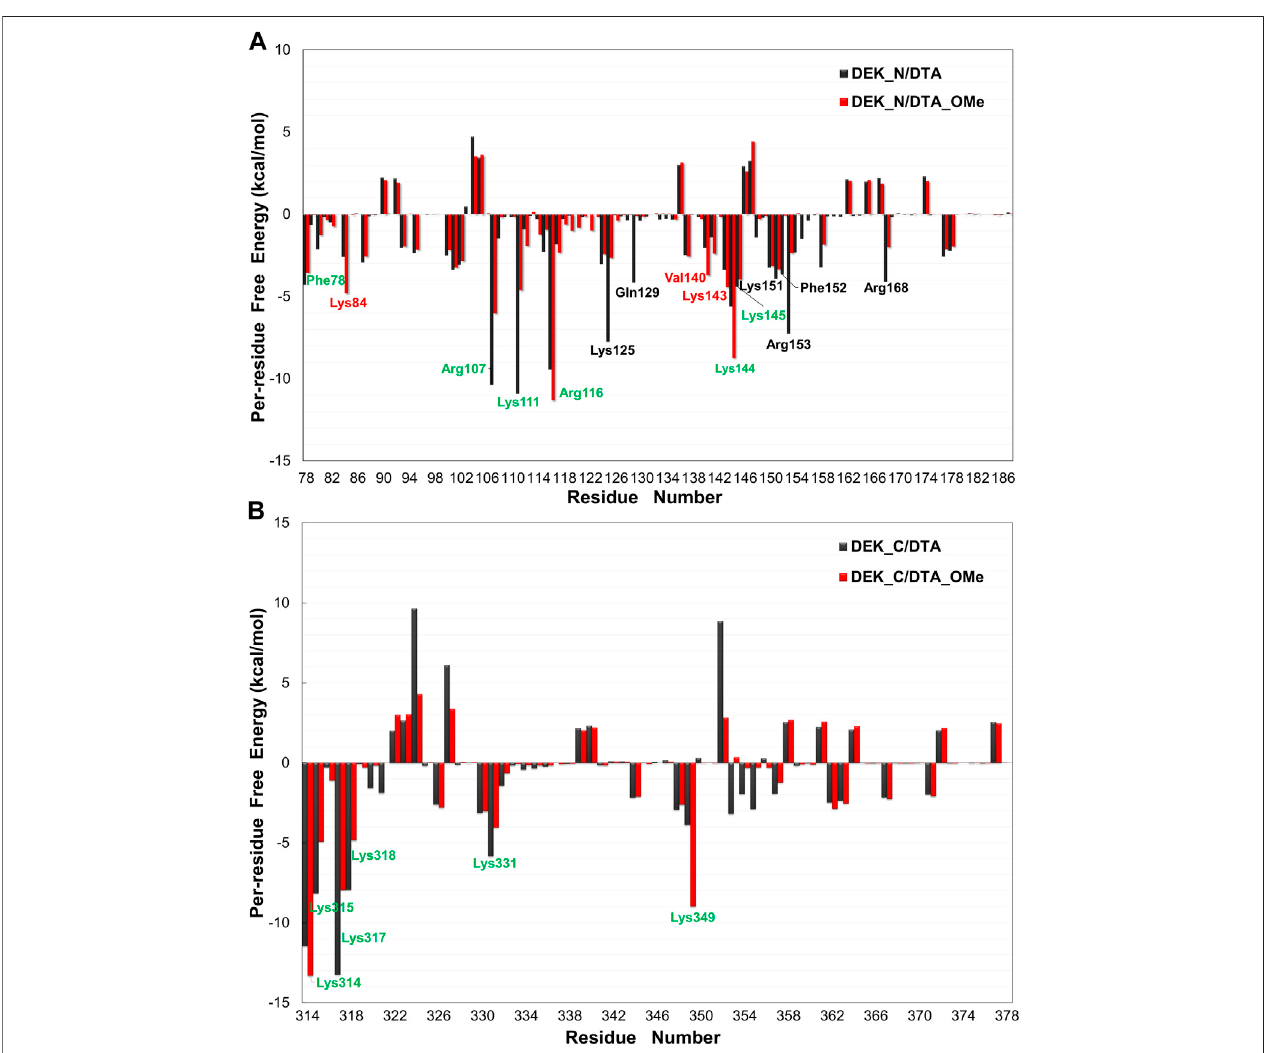
FIGURE 7 | Per-residue free energy decomposition diagrams of different protein – DNA complexes. (A) DEK_N/DTA, DEK_N/DTA_OMe complexes. (B) DEK_C/ DTA, DEK_C/DTA_OMe complexes. The residues with energies less than − 3.50 kcal/mol are marked with different colors. Among them, the black and red letters represent the different main residues present in the DEK_N/DTA and DEK_N/DTA_OMe complexes, respectively. The green letters represent the main residues present in both complexes.